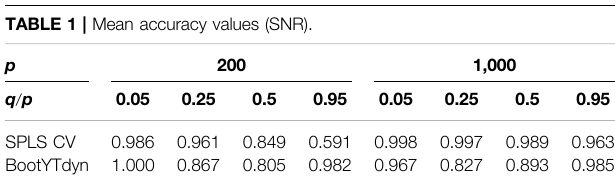
TABLE 1 | Mean accuracy values (SNR).